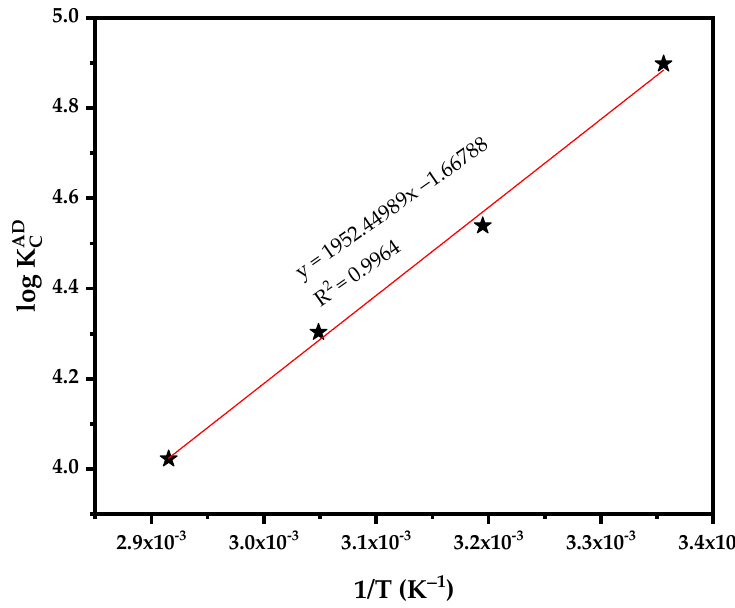
Figure 7. Van’t Hoff plot for the TIGC-TCNQ complex.